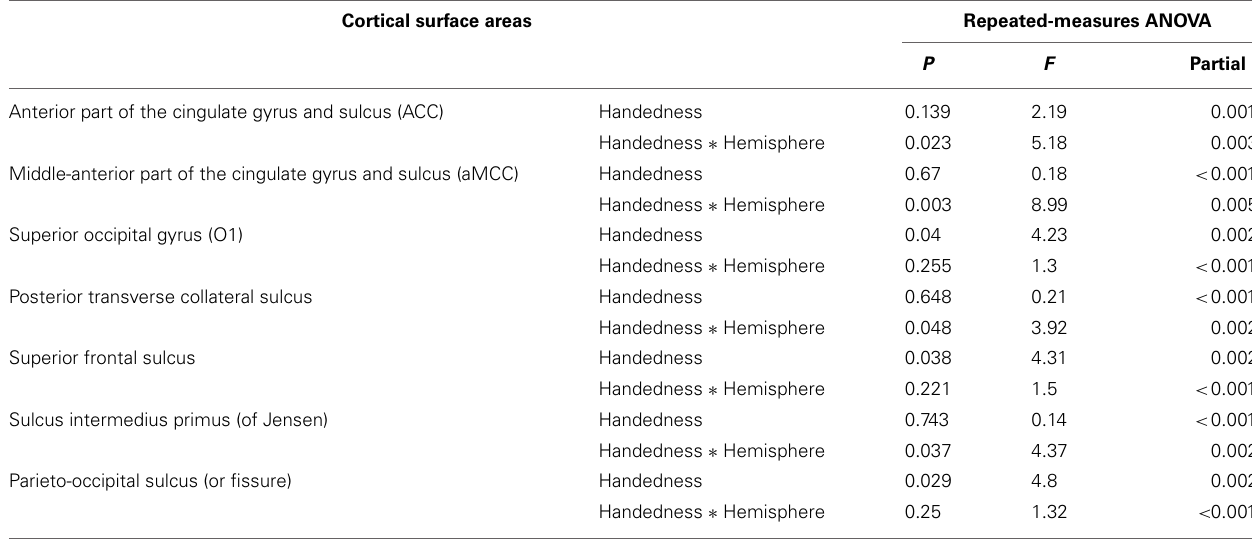
Table 5 | Summary results for non-candidate cortical regions that achieved nominal significance in ANOVA.